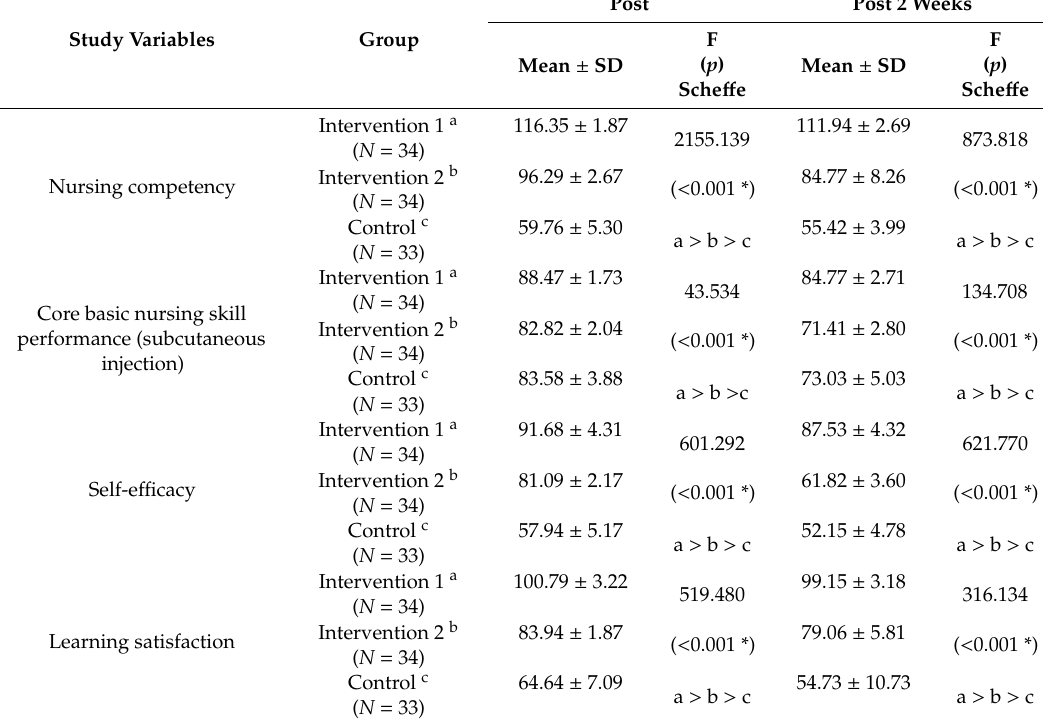
Table 3. E ff ects of simulation practicum using flipped learning at the immediately after and two weeks after experimental